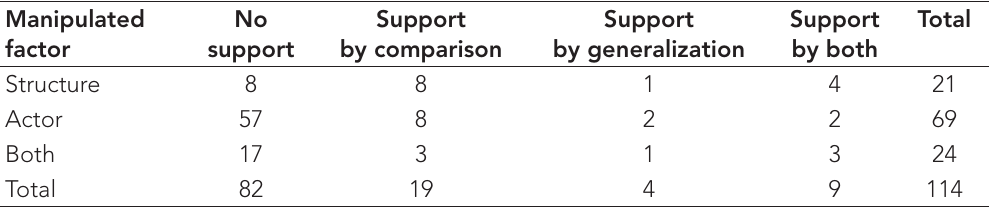
Table 4: Presence of support by comparison/generalization